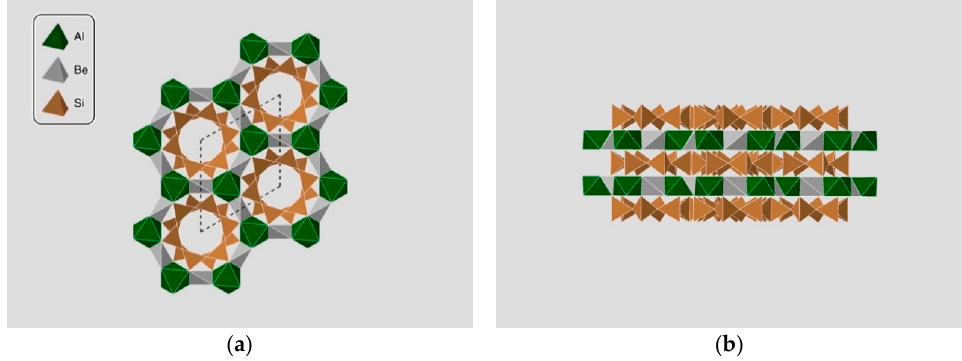
Figure 1. Crystal structure of beryl perpendicular ( a ) and parallel ( b ) to c-axis. Empty channels are mentioned with black dashed line (designed in Crystal Maker).